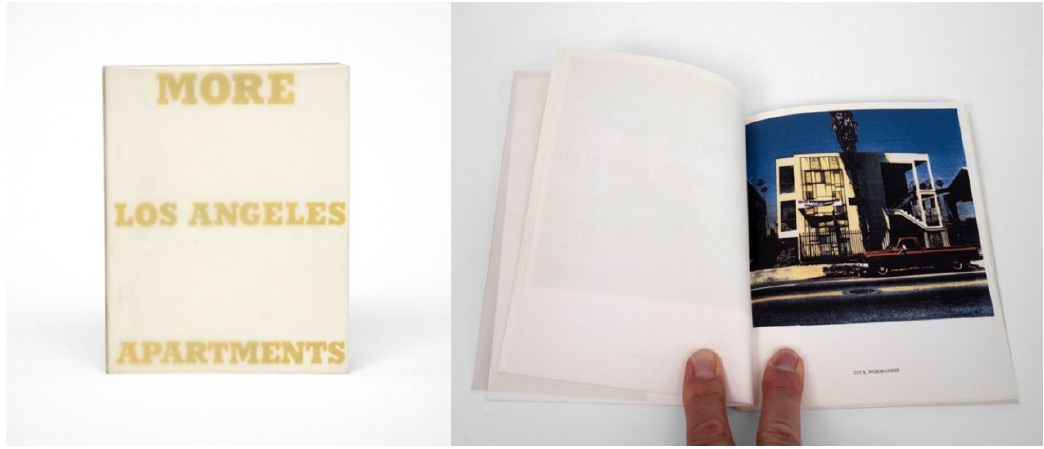
Figure 22. John O’Brian, More Los Angeles Apartments: And Twenty Three Min Photo , 1998.